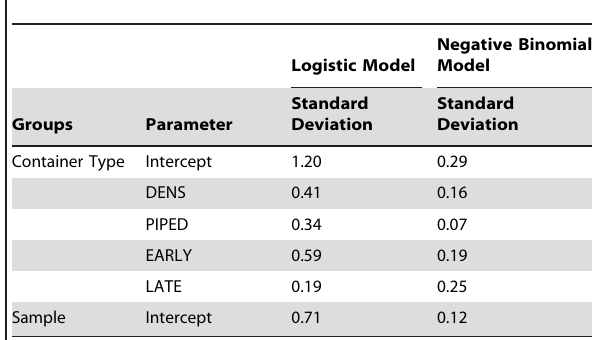
Table 3. Group-level variability among model